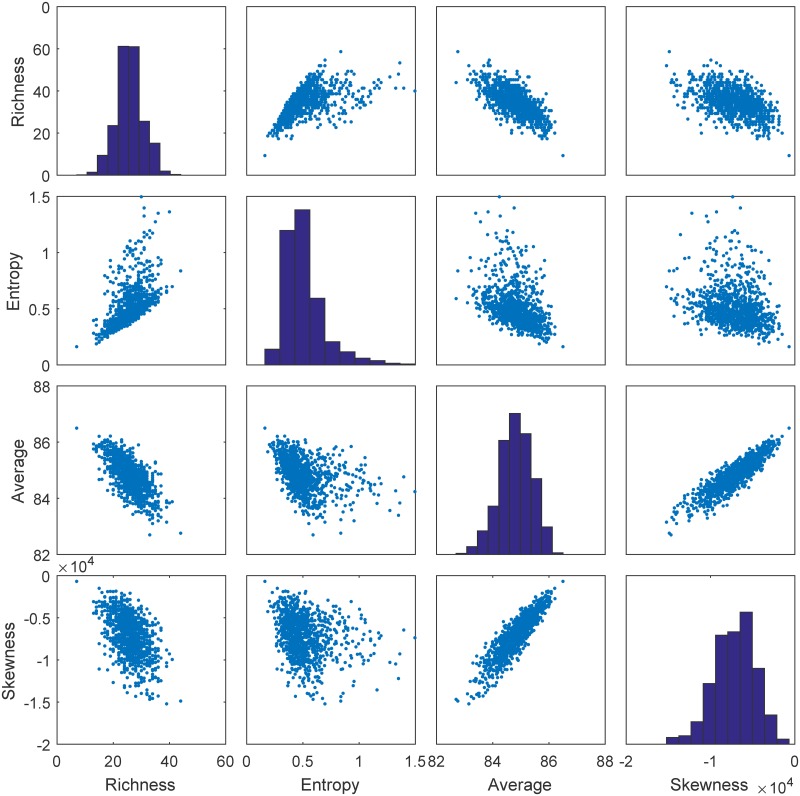
Samples for Tobs = 1 of the summary statistics of the trait model for parameter set log(I) = 3.0621, log(A) = 0.8302, h = 86.8924 and log(σ) = −0.6899.